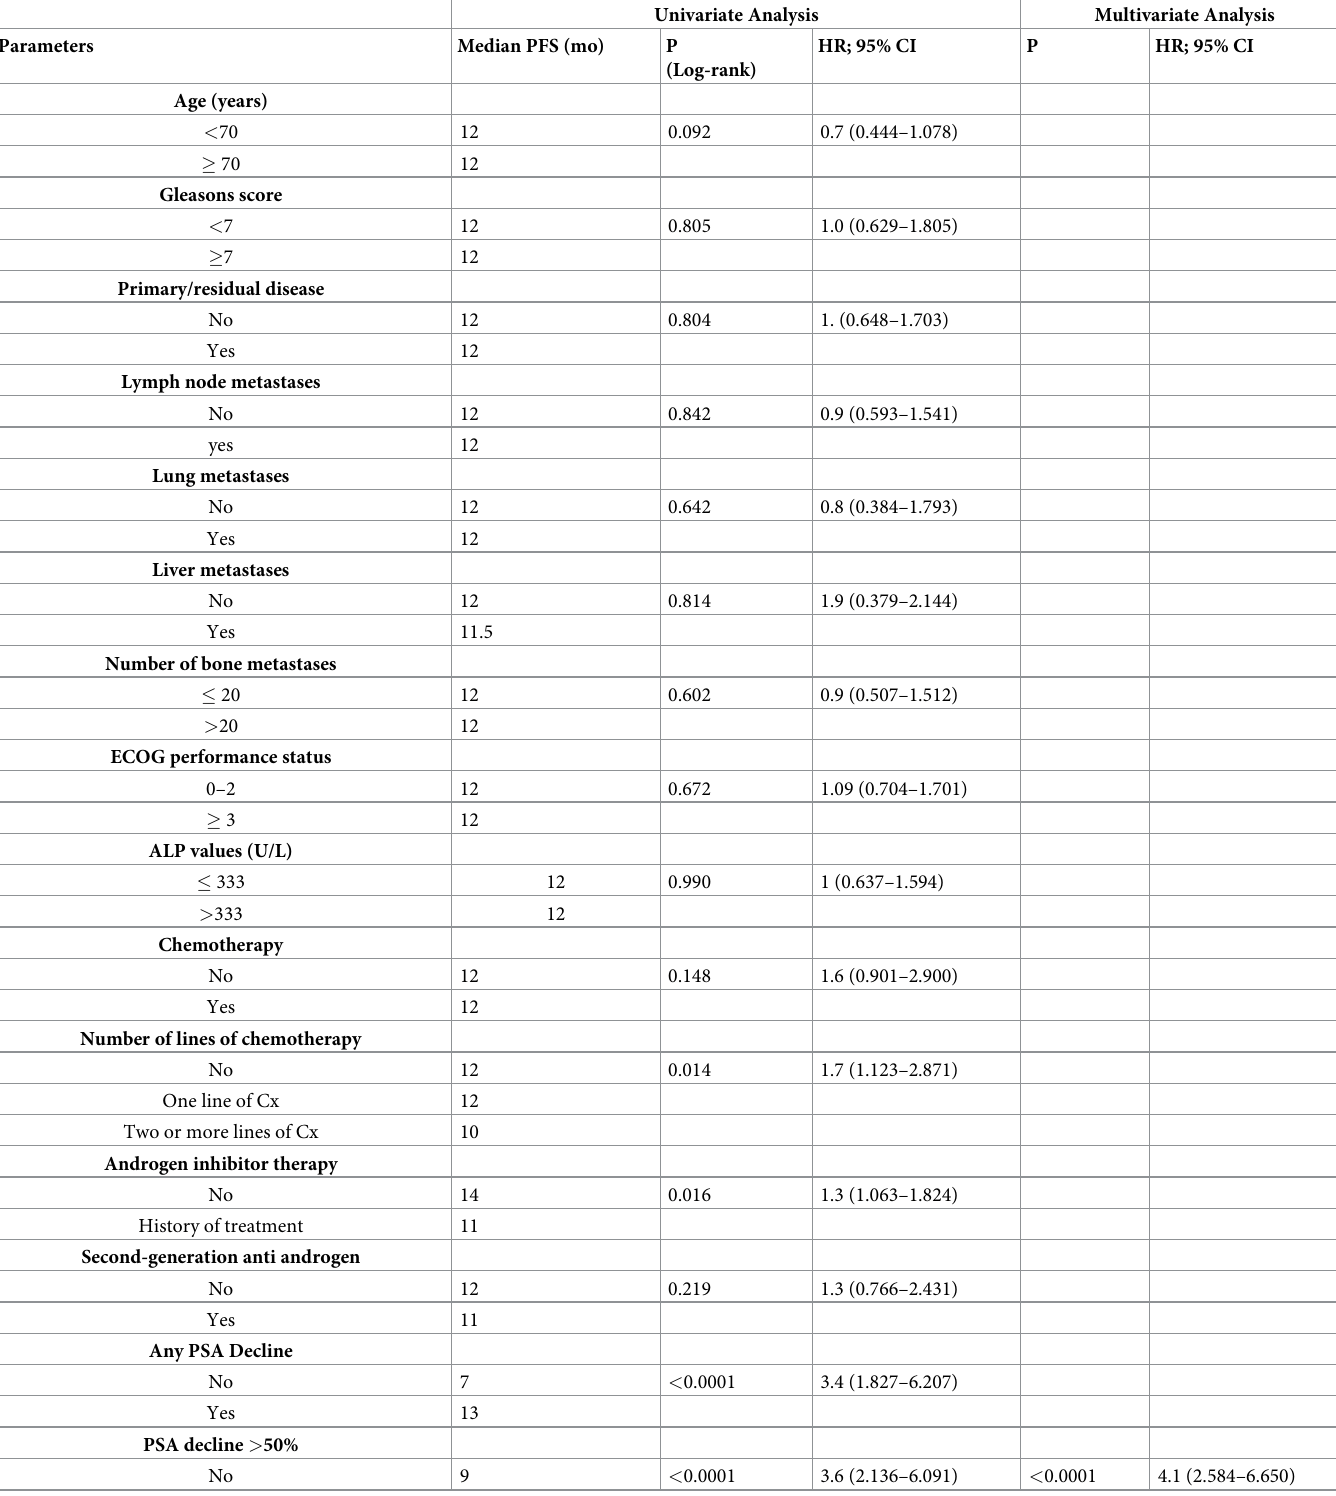
Table 2. Univariate and multivariate Cox proportional hazard regression of factors associated with progression-free